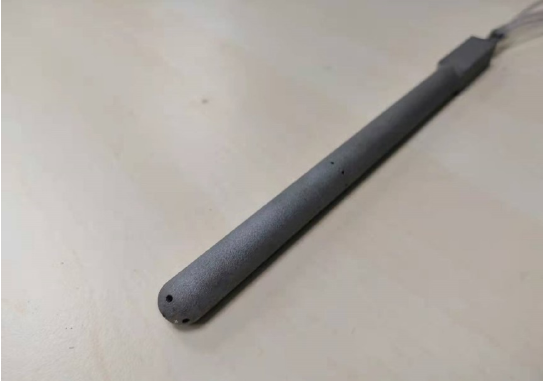
Figure 2. The five-hole probe.